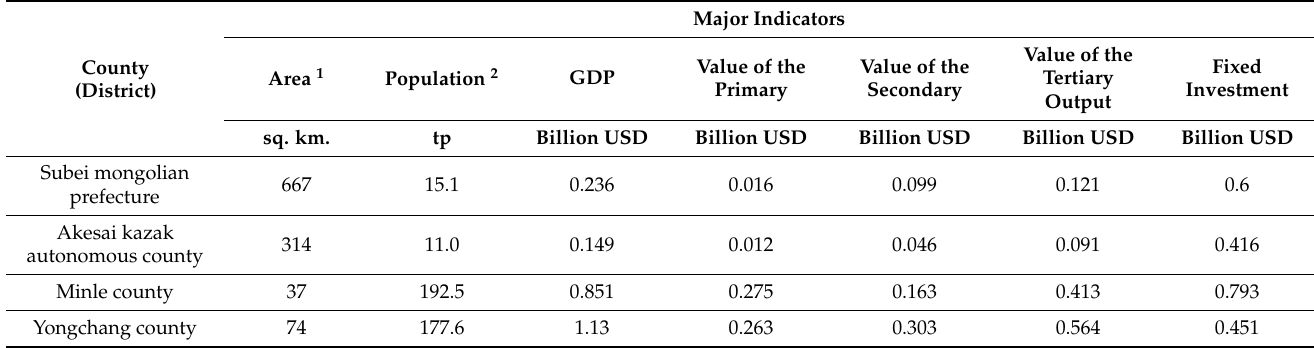
Table 1. Statistics of major indicators of Qilian Mountain National Park (Gansu Area) in